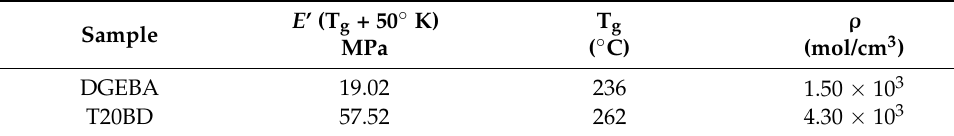
Table 3. Crosslink parameters.